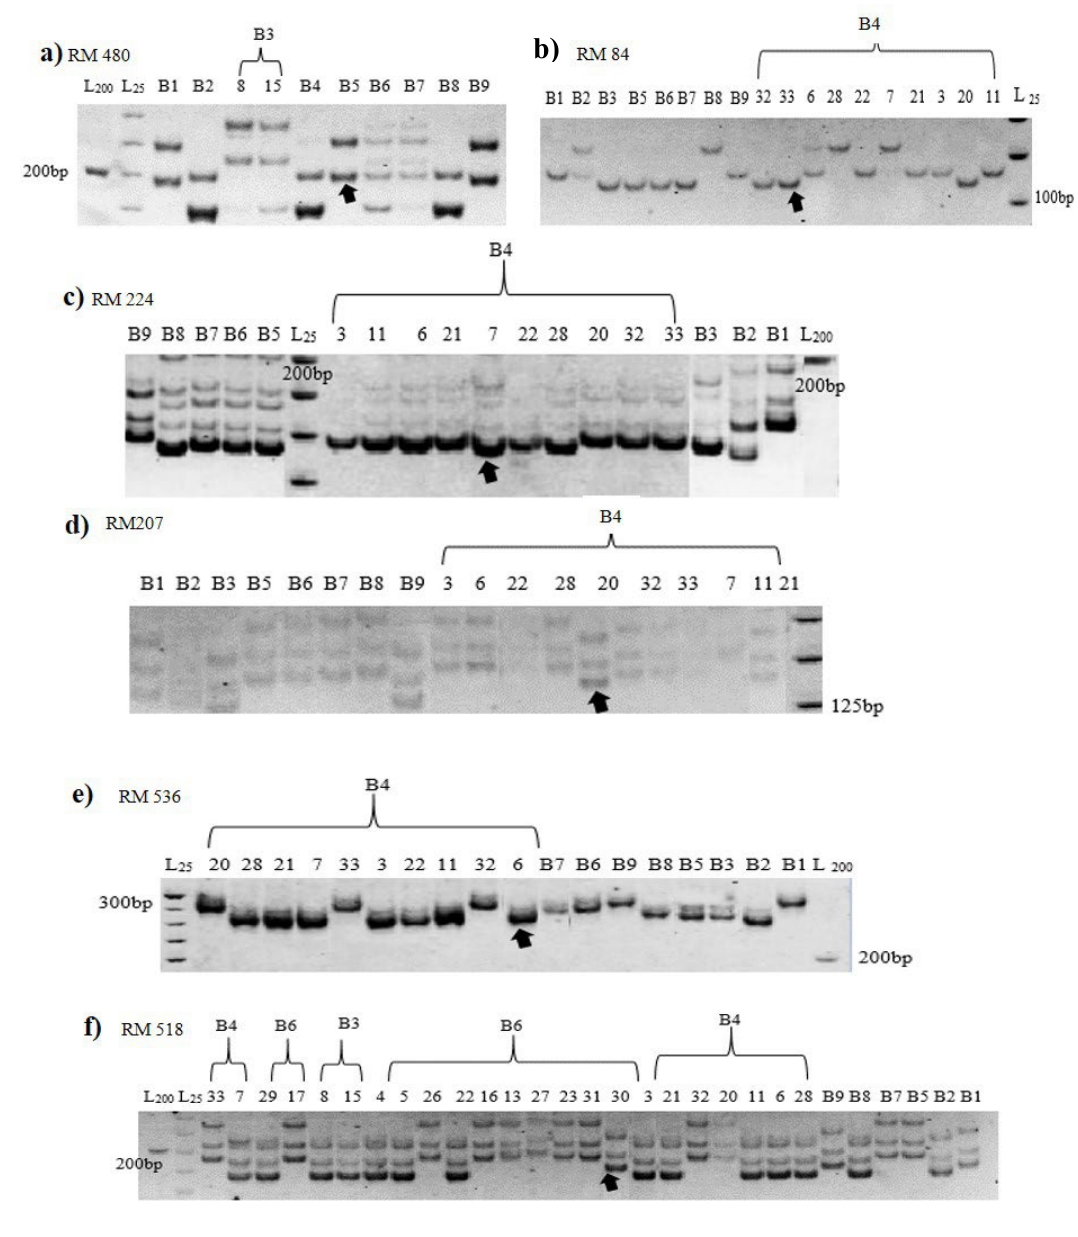
Supplemental Figure 3: PCR profiles of expanded DNA bulks